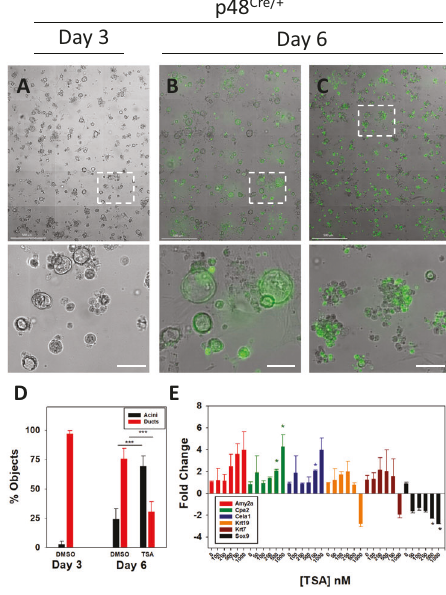
Fig. 4 Reversal of ADM by TSA in p48 Cre/ + mouse acini. p48 Cre/ + mouse pancreatic acini underwent ADM over 3 days of culture ( A ) and were then exposed to DMSO ( B ) or 1 µM TSA ( C ) for 3 additional days followed by Calcein AM viability staining. Shown are the high content images, with the enlarged sections (dashed lines) in the lower panels. Scale bars in the top images represent 500 µm and in the lower images 100 µm. D Acini and ducts were microscopically counted from four sections of the high content images. E Expression of acinar and ductal genes from TSA treated p48 Cre/ + mouse pancreatic organoids following the identical treatment as in ( A – C ). Data are presented as fold-change normalized to 18S rRNA and relative to the untreated control. Mean ± SD from duplicate experiments. * P < 0.05; *** P < 0.001. acinar phenotype to our knowledge (Fig. 9D). The top ten upstream chemical drugs were ranked and TSA was the sixth most highly ranked chemical (Fig. 9E). Pathways affected by LLL12B were less ADM and pancreas-related compared to those affected by TSA (SFig. 7A – D). Stat3 ranked eighth in terms of inhibited upstream transcriptional regulators by LLL12B (SFig. 7C). A complete list of all pathways, transcriptional regulators, and drugs affected by TSA or LLL12B may be found in Supplemental Table 3.